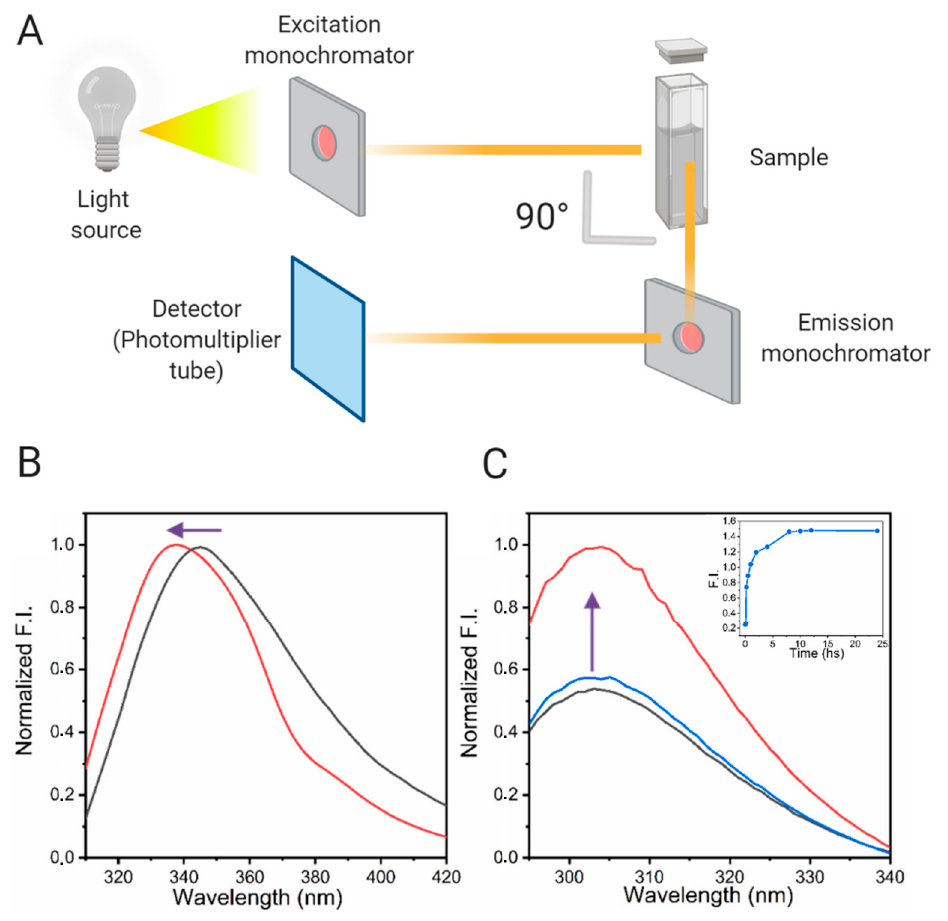
Figure 6. ( A ) Schematic representation of a Fluorometer instrument. ( B ) Tryptophan fluorescence spectra of a protein before (black) and after (red) the fibrillation process. Notice the blue-shift of the signal due to the change to a less polar environment. ( C ) Fluorescence spectra of a protein containing tyrosine (without any tryptophan), at 0 h (black), 1 h (blue) and 24 h (red) of the oligomerization process started. Insert a kinetic curve is presented. Notice the increment of the fluorescence intensity over time. This figure was created with BioRender.com.